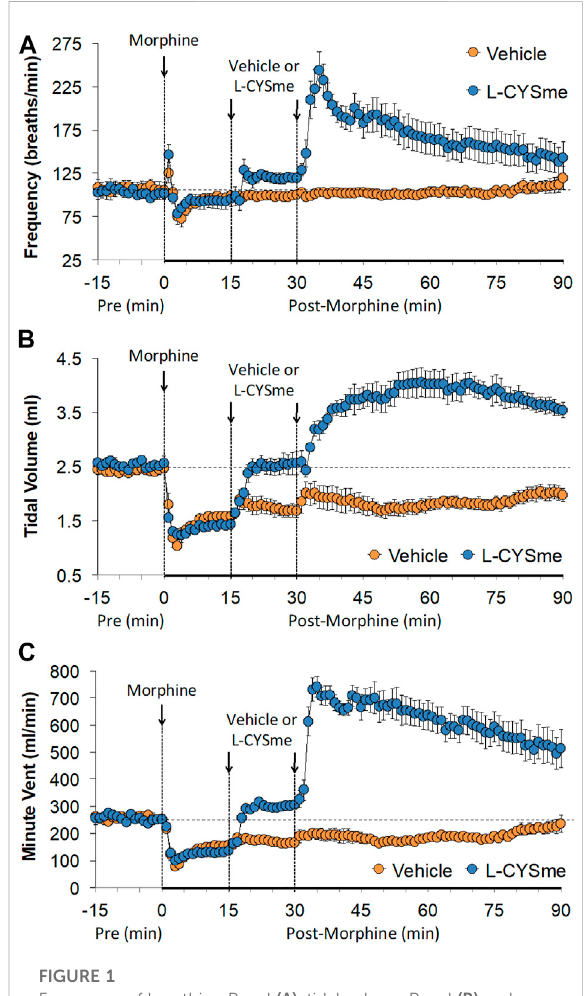
FIGURE 1 Frequency of breathing Panel (A) , tidal volume Panel (B) and minuteventilationPanel (C) priorto(Pre),followingtheinjectionof morphine (10 mg/kg, IV), and then two injections of vehicle or L-cysteine methyl ester (L-CYSme, 500 μ mol/kg, IV) given 15 min apart, in freely-moving rats. The data are presented as mean ± SEM. There were 6 rats in each